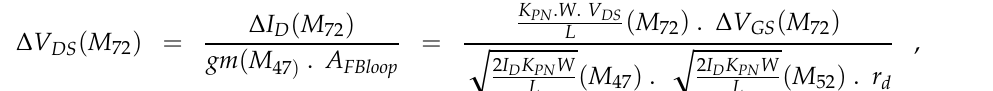
Figure 5. Slightly simplified schematic of the tunable transconductance stage. The circuit operation consists of a differential connection of two transconducting transistors M 72 , M 69 working in their linear region. It means, they both work according to the Equation (1) as well. From that equation can be seen that if V DS is kept constant then the drain current I D is controlled just by V GS of the transistor with strongly linear dependence, called transconductance gm .